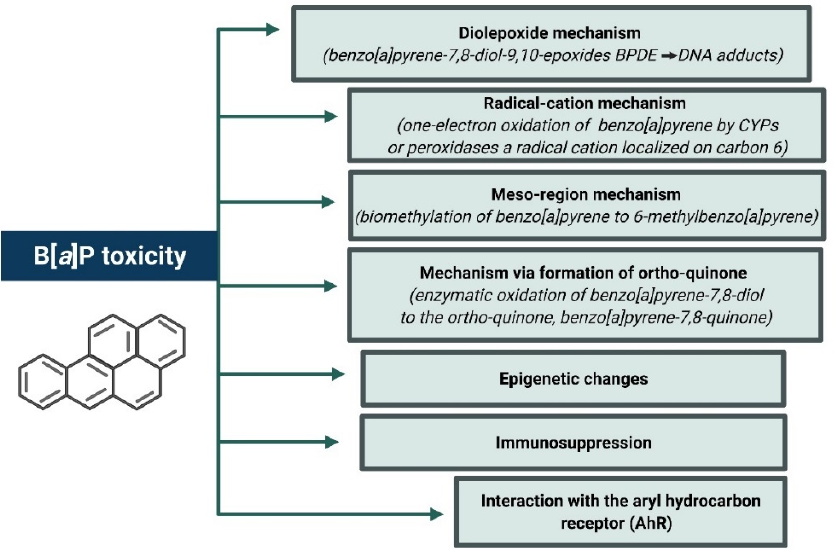
Figure 4. Mechanisms of B[ a ]P toxicity. Created with BioRender.com (accessed on 12 April 2022).